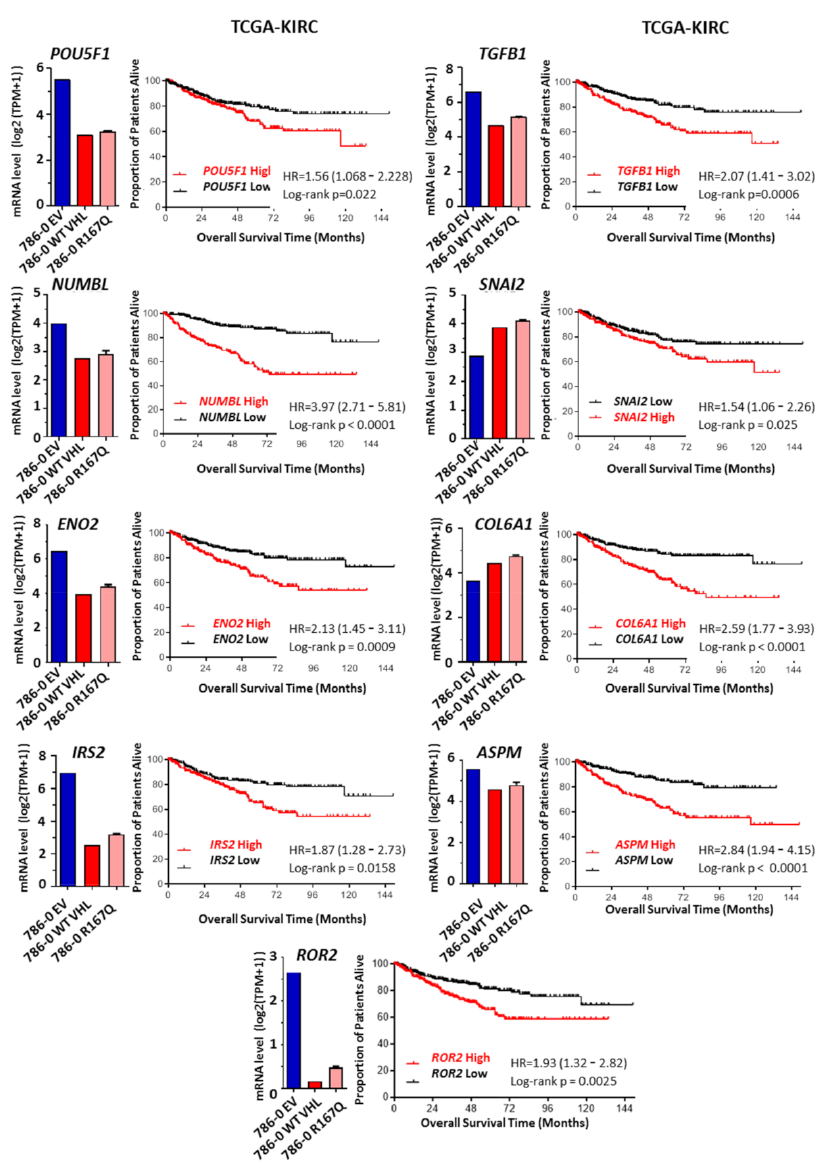
Figure 5. A set of VHL-regulated genes enriched in VHL-R167Q is associated with poor survival in the RCC TCGA dataset. Kaplan–Meier curves were generated to analyze the association between patient survival and mRNA expression of ENO2 , IRS2 , ROR2 , POU5F1 , NUMBL , TGFB1 , SNAI2 , COL6A1 , ASPM genes in RCC tumors of the TCGA KIRC. Patients were stratified into two groups (low and high expression). The bar graphs show log2-transformed expression in the three 786-0